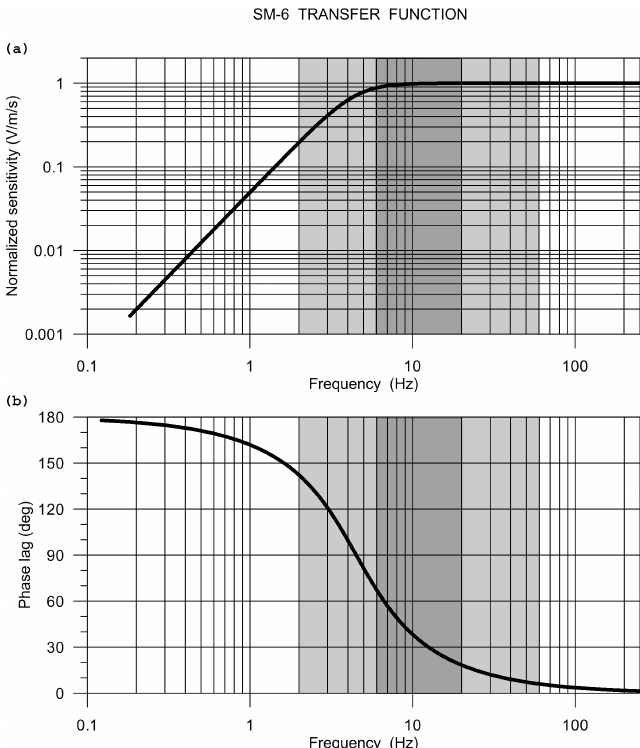
Figure 5. The SM-6 frequency response: modulus ( a ) and phase ( b ). The response is calculated from poles and zeros specified by the manufacturer. Grey intervals indicate Rotaphone frequency range, the dark grey rectangles mark the range actually considered in the comparative